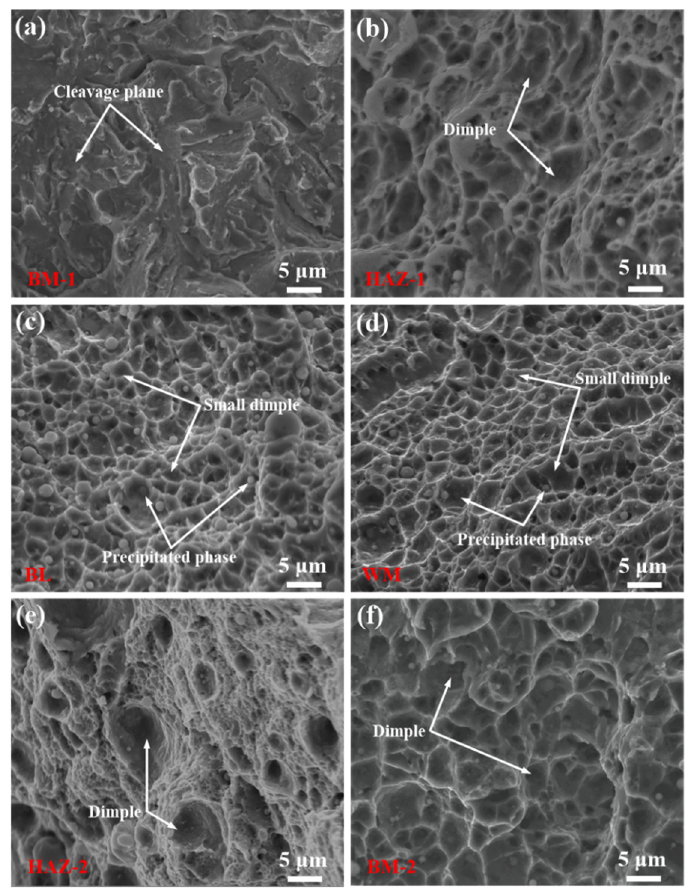
Figure 6. ( a – f ) Fracture surfaces in different regions of